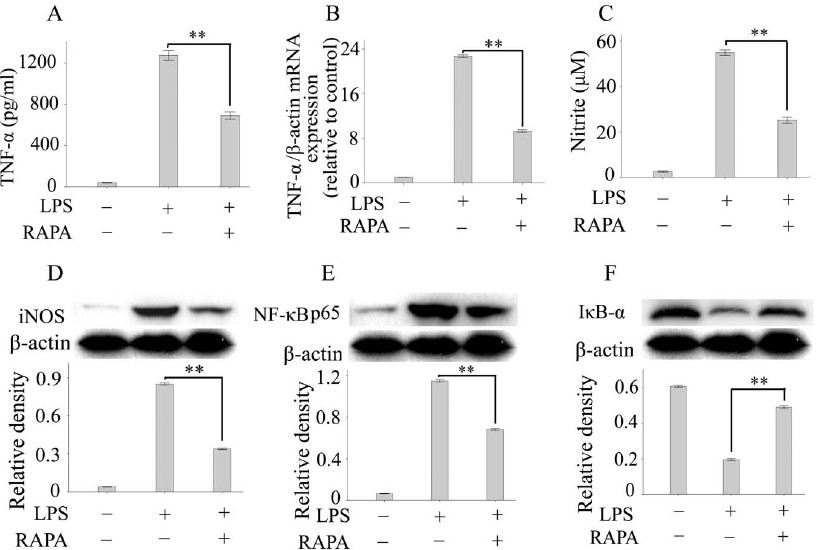
Figure 3. Rapamycin inhibited neurotoxic mediator release in microglia by modulating NF- k B signaling. BV2 microglia were plated in six-well plates for 24 hours and subsequently stimulated with LPS for another 16 hours in the presence or absence of rapamycin. The TNF- a level (A) in the supernatants and the expression of TNF- a mRNA (B) in microglia were determined by ELISA and real-time PCR, respectively. (C): The nitrite content in the supernatants was measured by the Griess reaction. The expression of iNOS (D), NF- k B (E) and I k B- a (F) in microglia was determined based on western blotting. Values are presented as the mean 6 SEM of 3 replicates, and experiments were repeated at least 2 times with similar results. ** p , 0.01. Abbreviations: LPS, lipopolysaccharides; RAPA, rapamycin; TNF- a , tumor necrosis factor-alpha; iNOS, induced nitric oxide synthase; NF- k B, nuclear factor-kappa B; I k B- a , I kappa B-alpha.